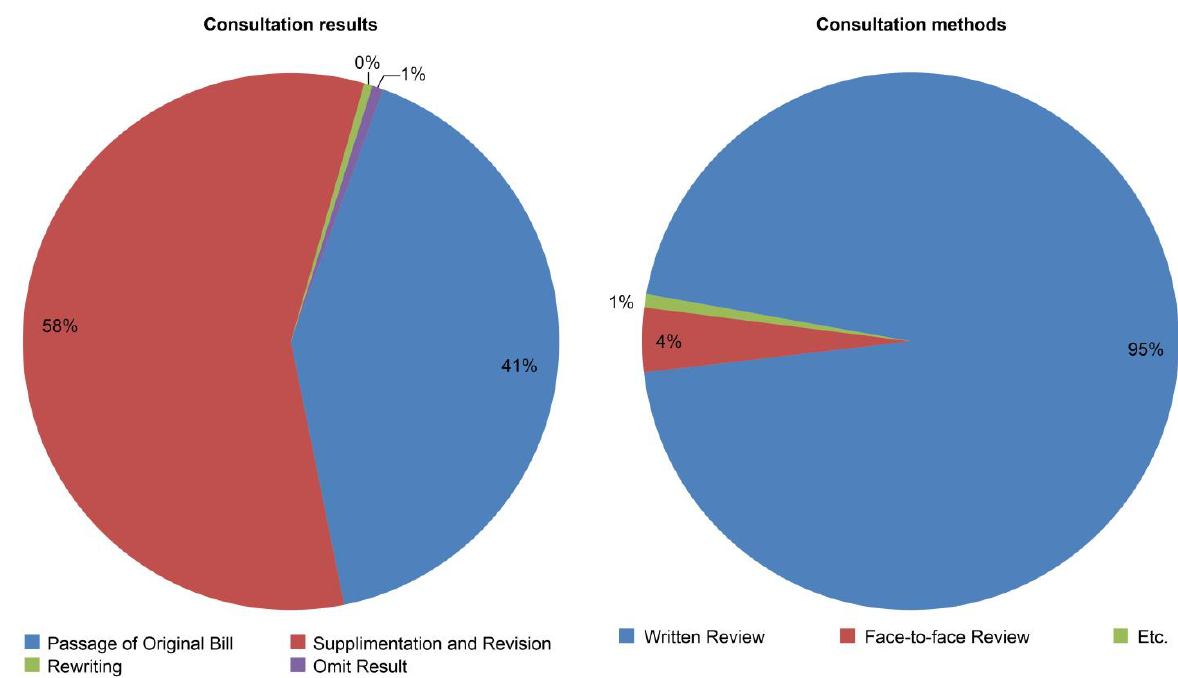
Figure 6. Consultation results and methods (2015 – 2017).